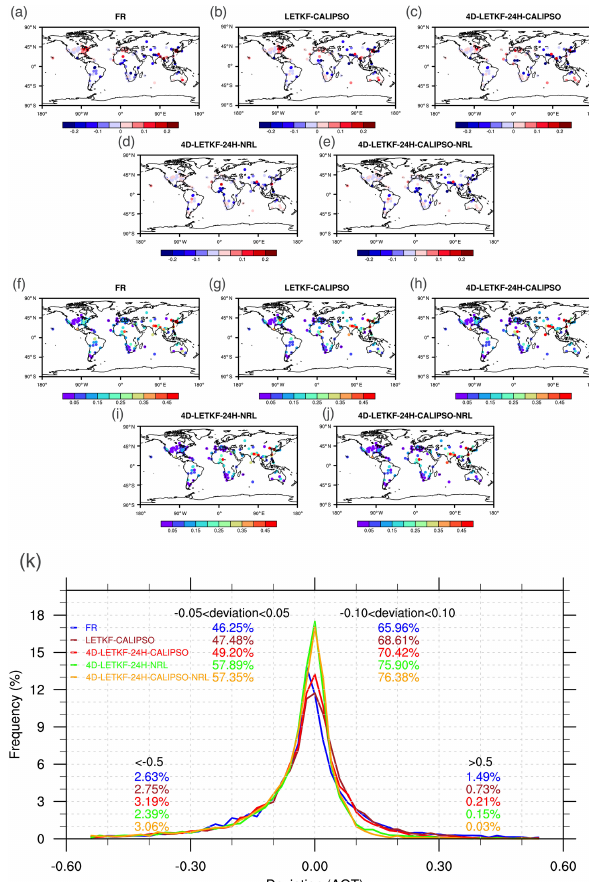
Figure 9. Same as Fig. 8 but for the simulated AOTs at 440nm against the AERONET-retrieved